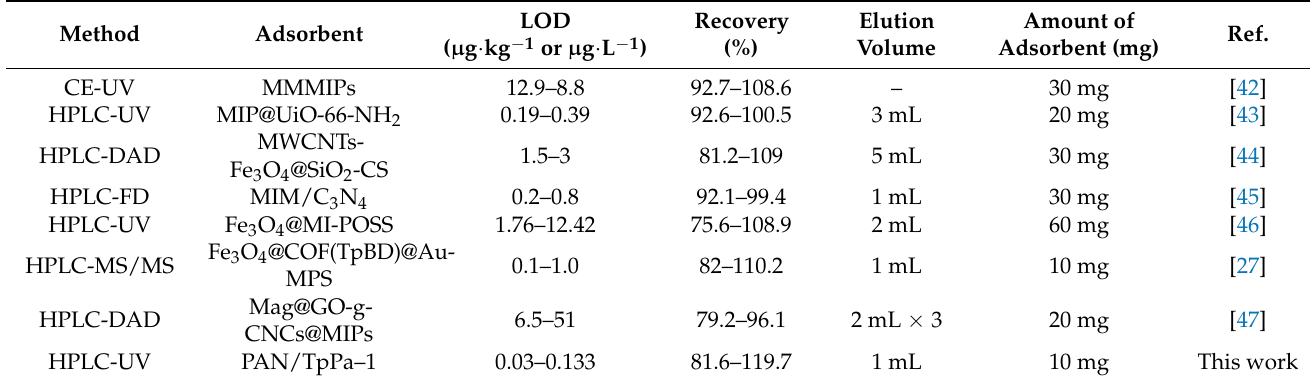
Table 3. Comparison of some methods for the determination of